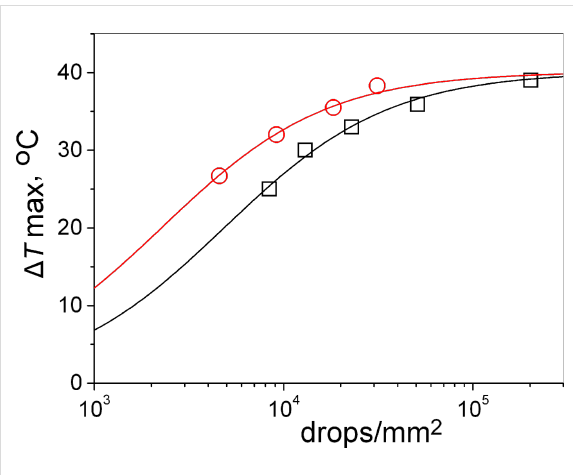
GNS for the non-permeable substrate (open circles) and the perme- able substrate (open squares). Laser intensity was 0.36 W/cm 2 . The solid lines are the best fit of the trial function (see Supporting Informa- tion File 2) to the